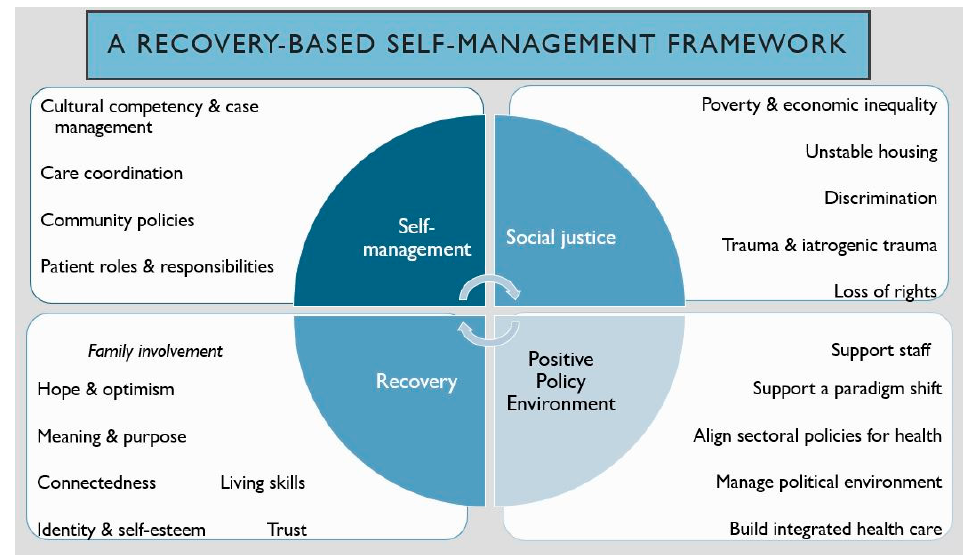
Figure 1. A recovery-based self-management framework.